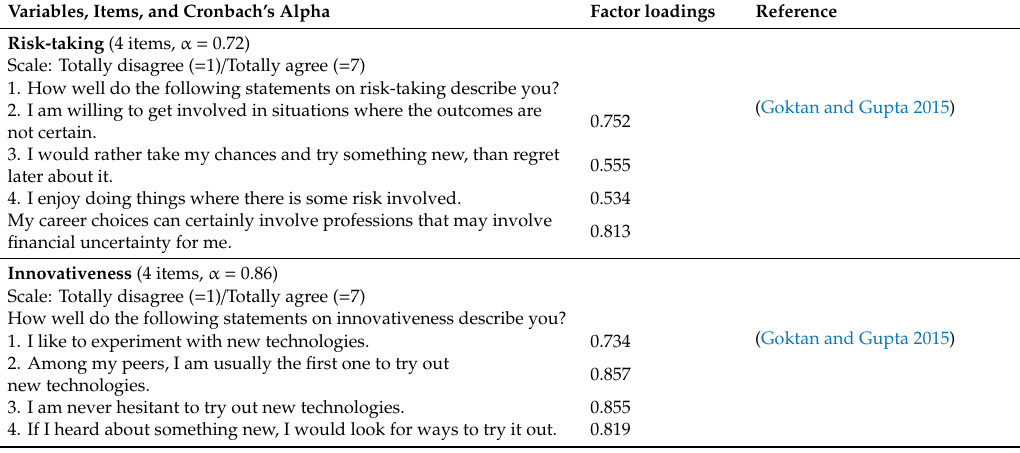
Table A1. Questionnaire variables: items, factor loadings, Cronbach’s Alpha, and references. Variables, Items, and Cronbach’s